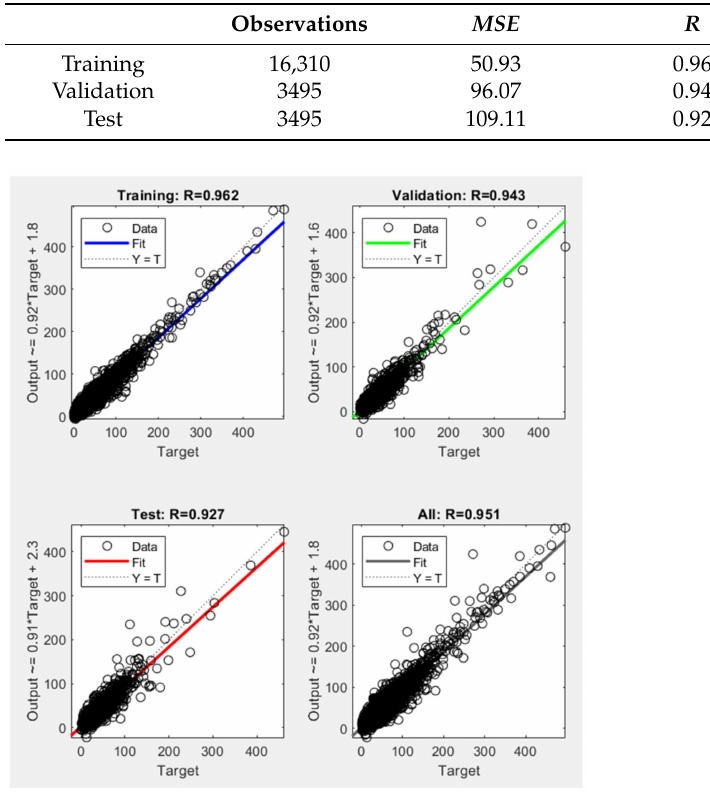
Figure 6. ANN regression statistics for individual sets and the total set.